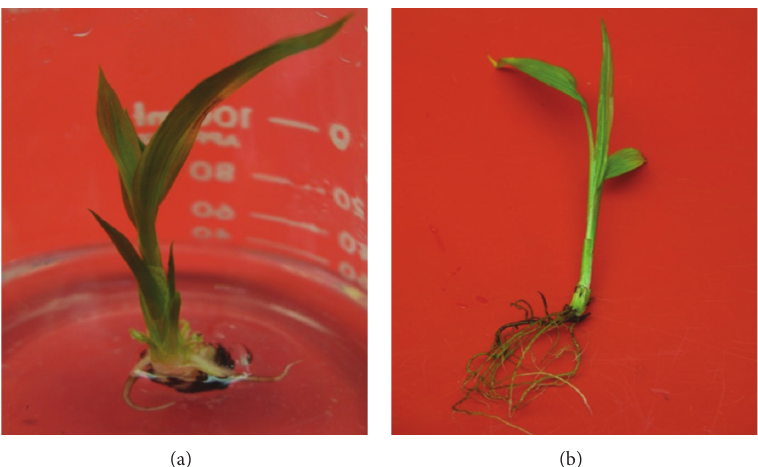
Figure 3: In vitro rooting of C. latifolia . (a) Emerged root form shoot after three weeks of transferring into MS free media and (b) a target plantlet with developed adventitious